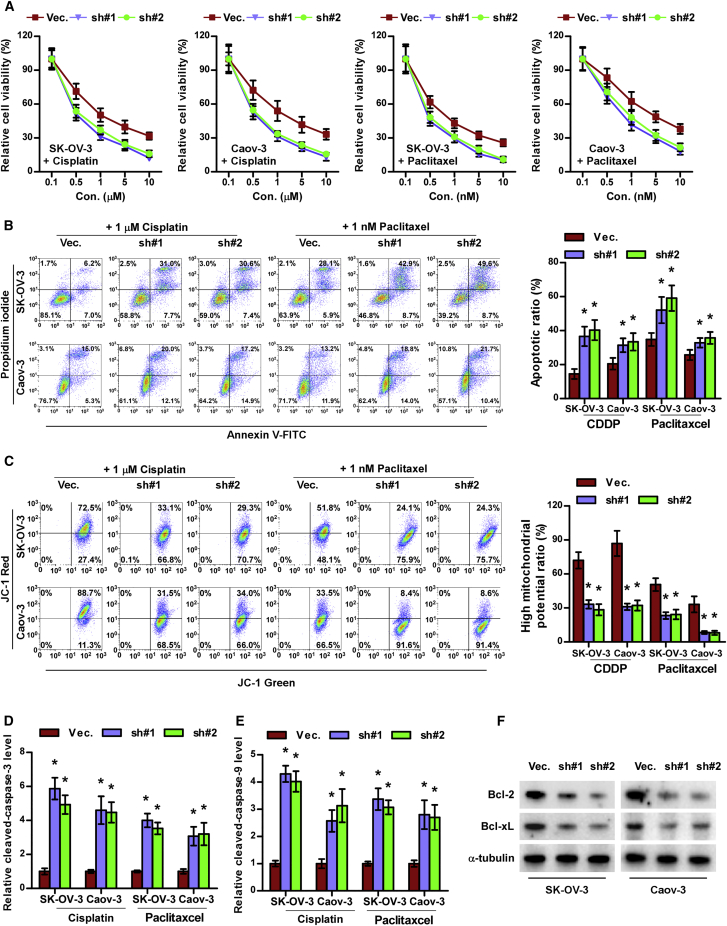
Silencing LGR6 Attenuates Chemoresistance in Ovarian Cancer Cells(A) The effect of LGR6 silencing on cell viability of ovarian cancer cells. Error bars represent the mean ± SD of three independent experiments. *p < 0.05. (B and C) The effect of LGR6 silencing on apoptotic ratio (B) and mitochondrial potential (C) of ovarian cancer cells via flow cytometry. Error bars represent the mean ± SD of three independent experiments. *p < 0.05. (D and E) Analysis of the activities of caspase-3 (D) and caspase-9 (E) were detected by the cleaved forms of these two proteins. Error bars represent the mean ± SD of three independent experiments. *p < 0.05. (F) Western blotting analysis of Bcl-2 and Bcl-xL in the indicated cells. α-tubulin served as the loading control.